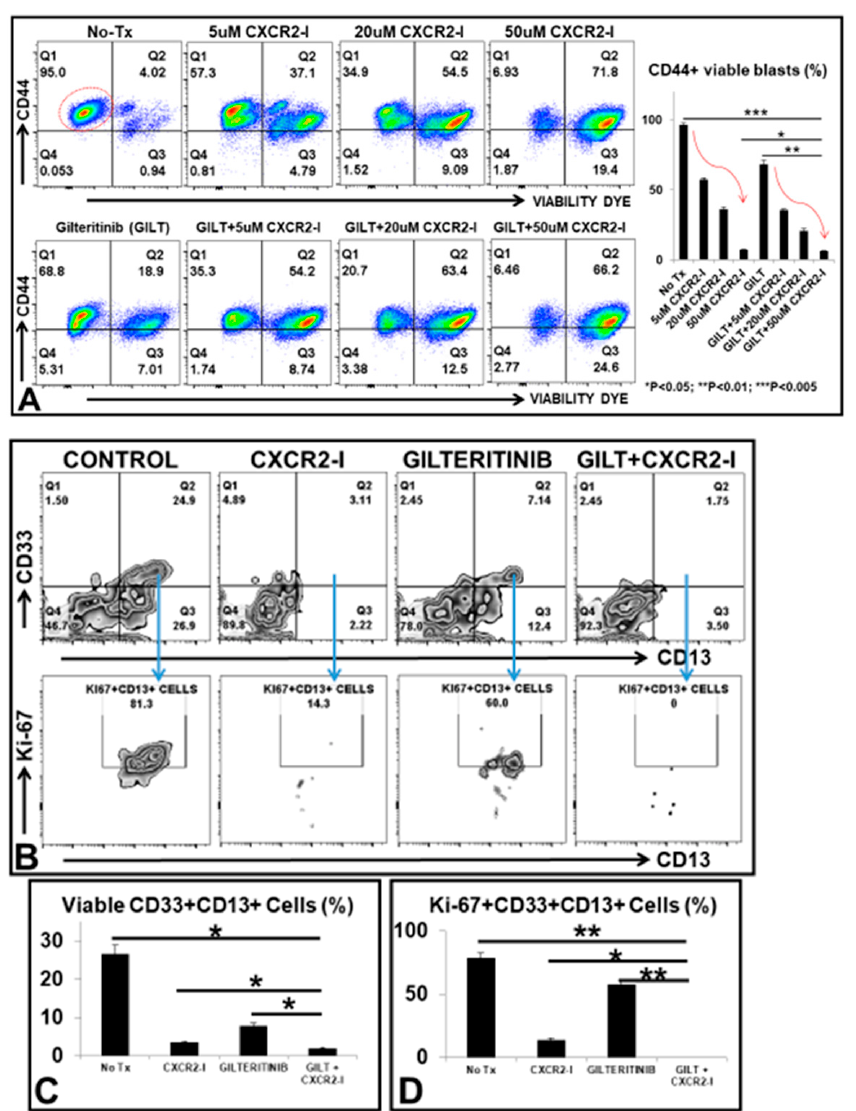
Figure 4. Therapeutic effect of the combination therapy of GILT and CXCR2-I on MV4-11 and primary AML-FLT3 BMMNC in vitro and ex vivo. ( A ) Representative FC plots of viable CD44+ MV4-11 cells (indicated by the red circle in the plot of No-Tx control) in different treatment groups including different doses of CXCR2-I alone or in combination with 80 nM GILT; Right bar chart: Cumulative FC percentage data of viable CD44+ blasts; Red curve arrows indicate the trend of dose-dependent treatment efficacy; ( B ) Representative FC plots of viable CD33+CD13+ primary blasts (Patient #3) in different treatment groups; Blue arrows (Gating) indicate further analyses of Ki-67 expression of these viable CD33+CD13+ primary blasts; ( C ) Cumulative FC percentage data of viable CD33+CD13+ primary blasts; ( D ) Cumulative FC percentage data of viable Ki-67+CD33+CD13+ primary blasts; * p < 0.05, ** p < 0.01, *** p <